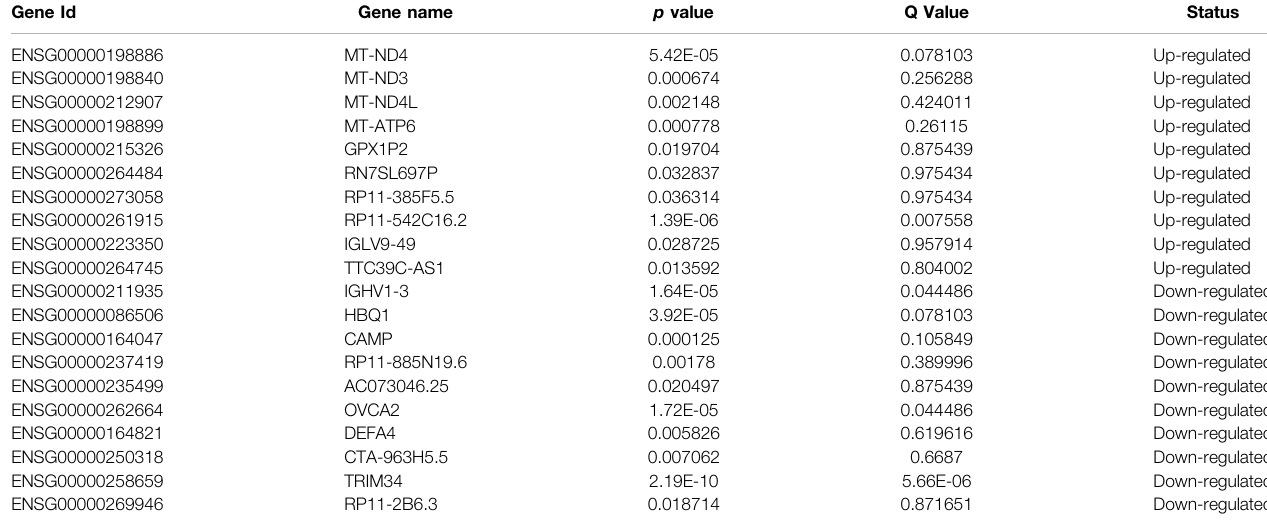
TABLE 3 | Top 10 signi fi cantly upregulated and downregulated mRNA between groups.